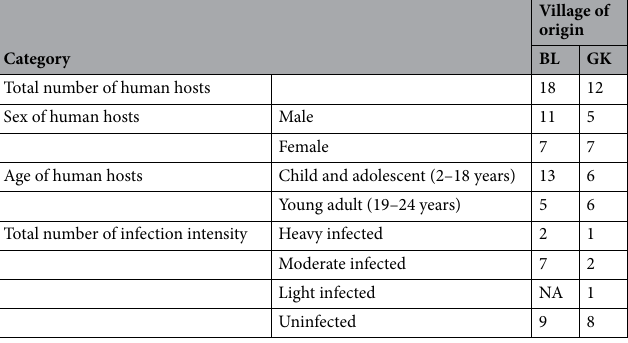
Table 2. The characteristics of human hosts from Ban Mae Salid Luang (BL) and Gre Key (GK) village. * NA not